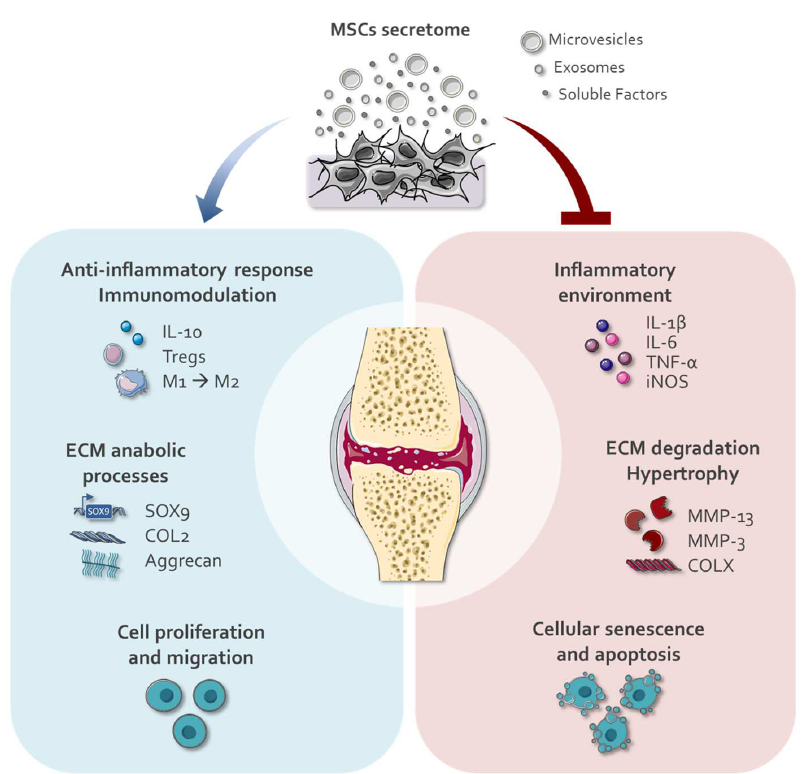
Figure 2. Effects of MSC secretome treatment on cartilage repair. Paracrine factors present in the MSCs secretome as soluble factors or contained in EVs (microvesicles and exosomes) can respond to cartilage injury. By inducing a decrease in the production of pro-inflammatory cytokines, a down- regulation of the matrix degradation through MMPs, and a reduction in cellular senescence and apoptosis, the MSCs secretome attenuates catabolic events at damaged cartilage. At the same time, the MSCs secretome favors cell proliferation and migration of chondrocytes, enhancing the expres- sion of genes involved in ECM synthesis and inducing an anti-inflammatory response. The images were obtained from Servier Medical Art (http://smart.servier.com/, Accessed on 7 April 2022), li-